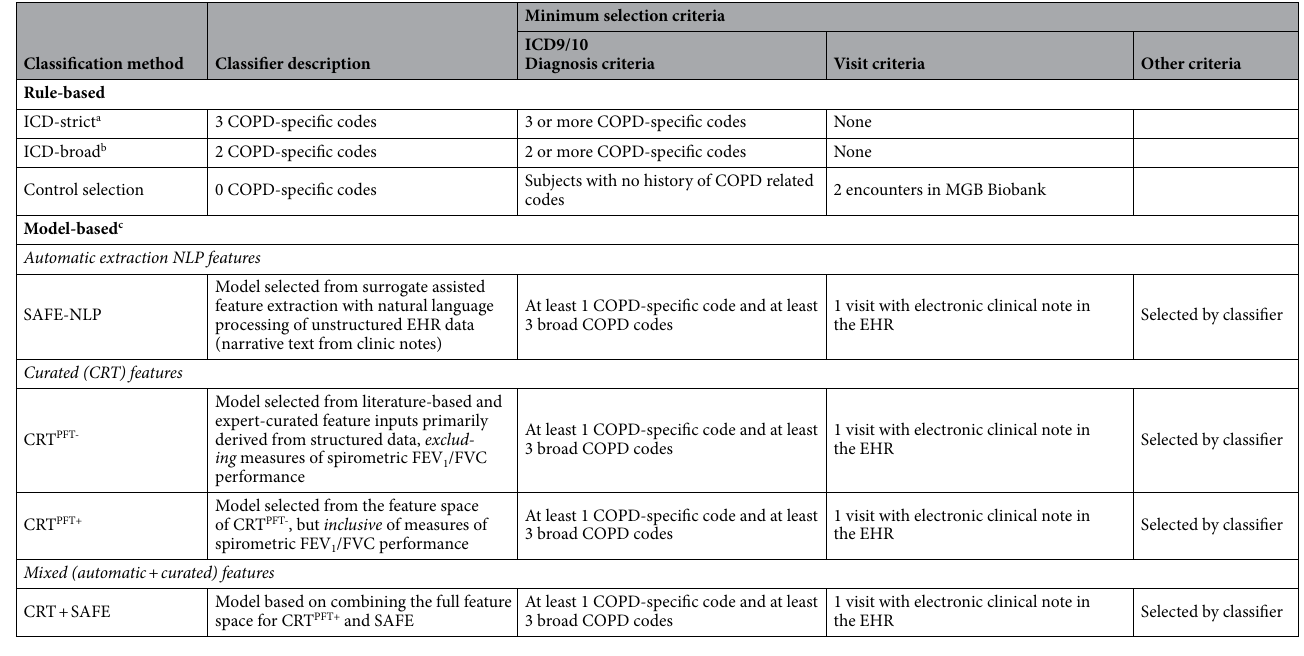
Table 1. Algorithms for classifying chronic obstructive pulmonary disease. a COPD-specific codes